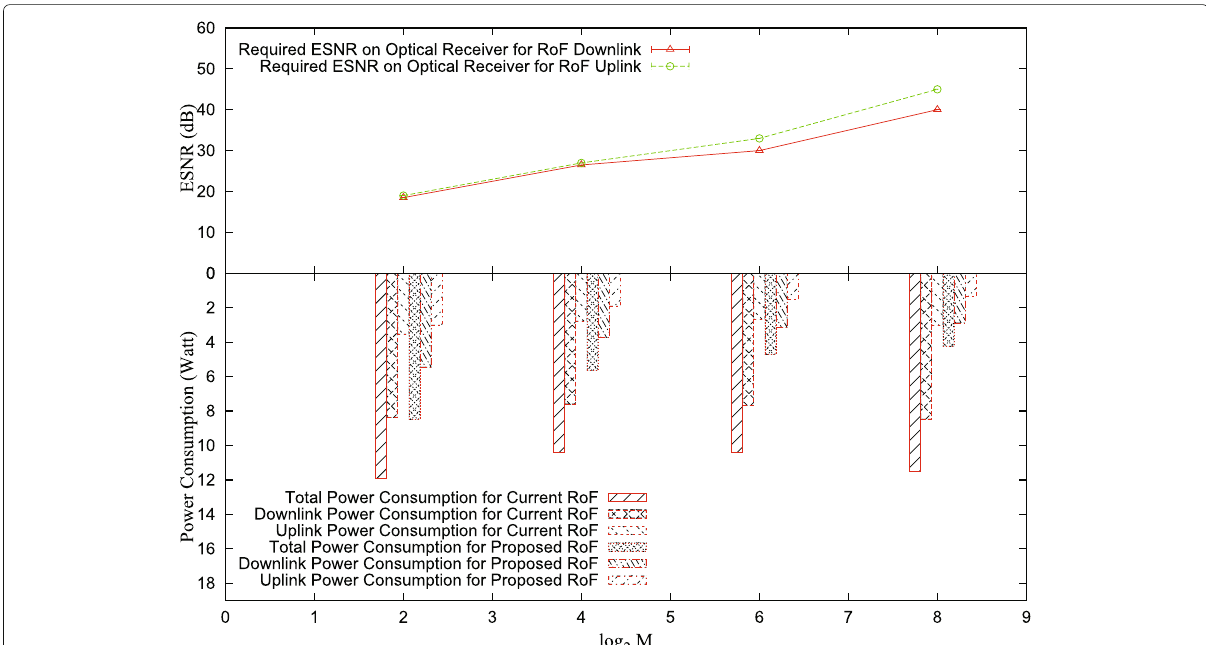
Fig. 5 Required ESNR on optical receiver and power consumption of RoF system for supporting a single BS with V π = 10 VS modulation